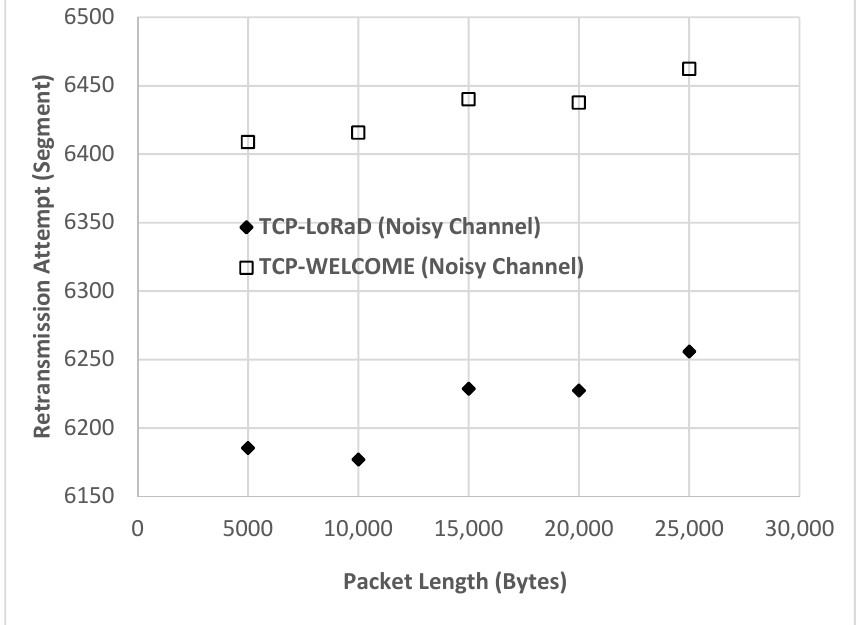
Figure 16. Retransmission attempt versus Packet Length in a noisy channel. Comparison of TCP-